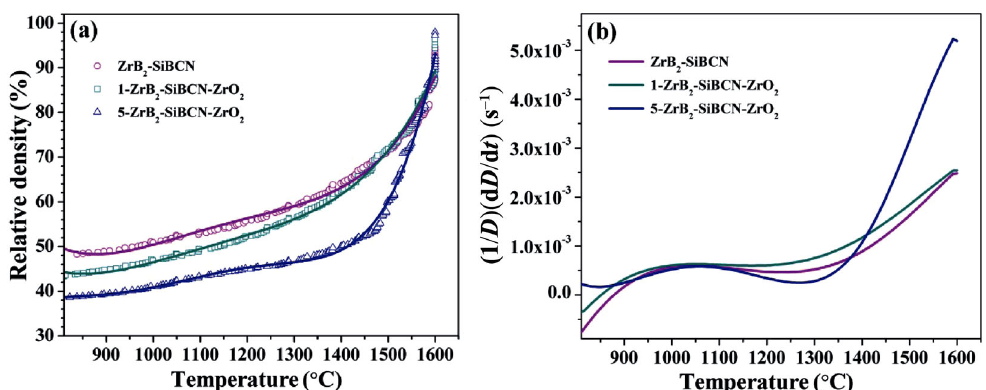
Fig. 5 (a) Continuous densification and (b) densification rate curves of ZrB 2 –SiBCN ceramics with different contents of ZrO 2 sintered at 1600 ℃ for 15